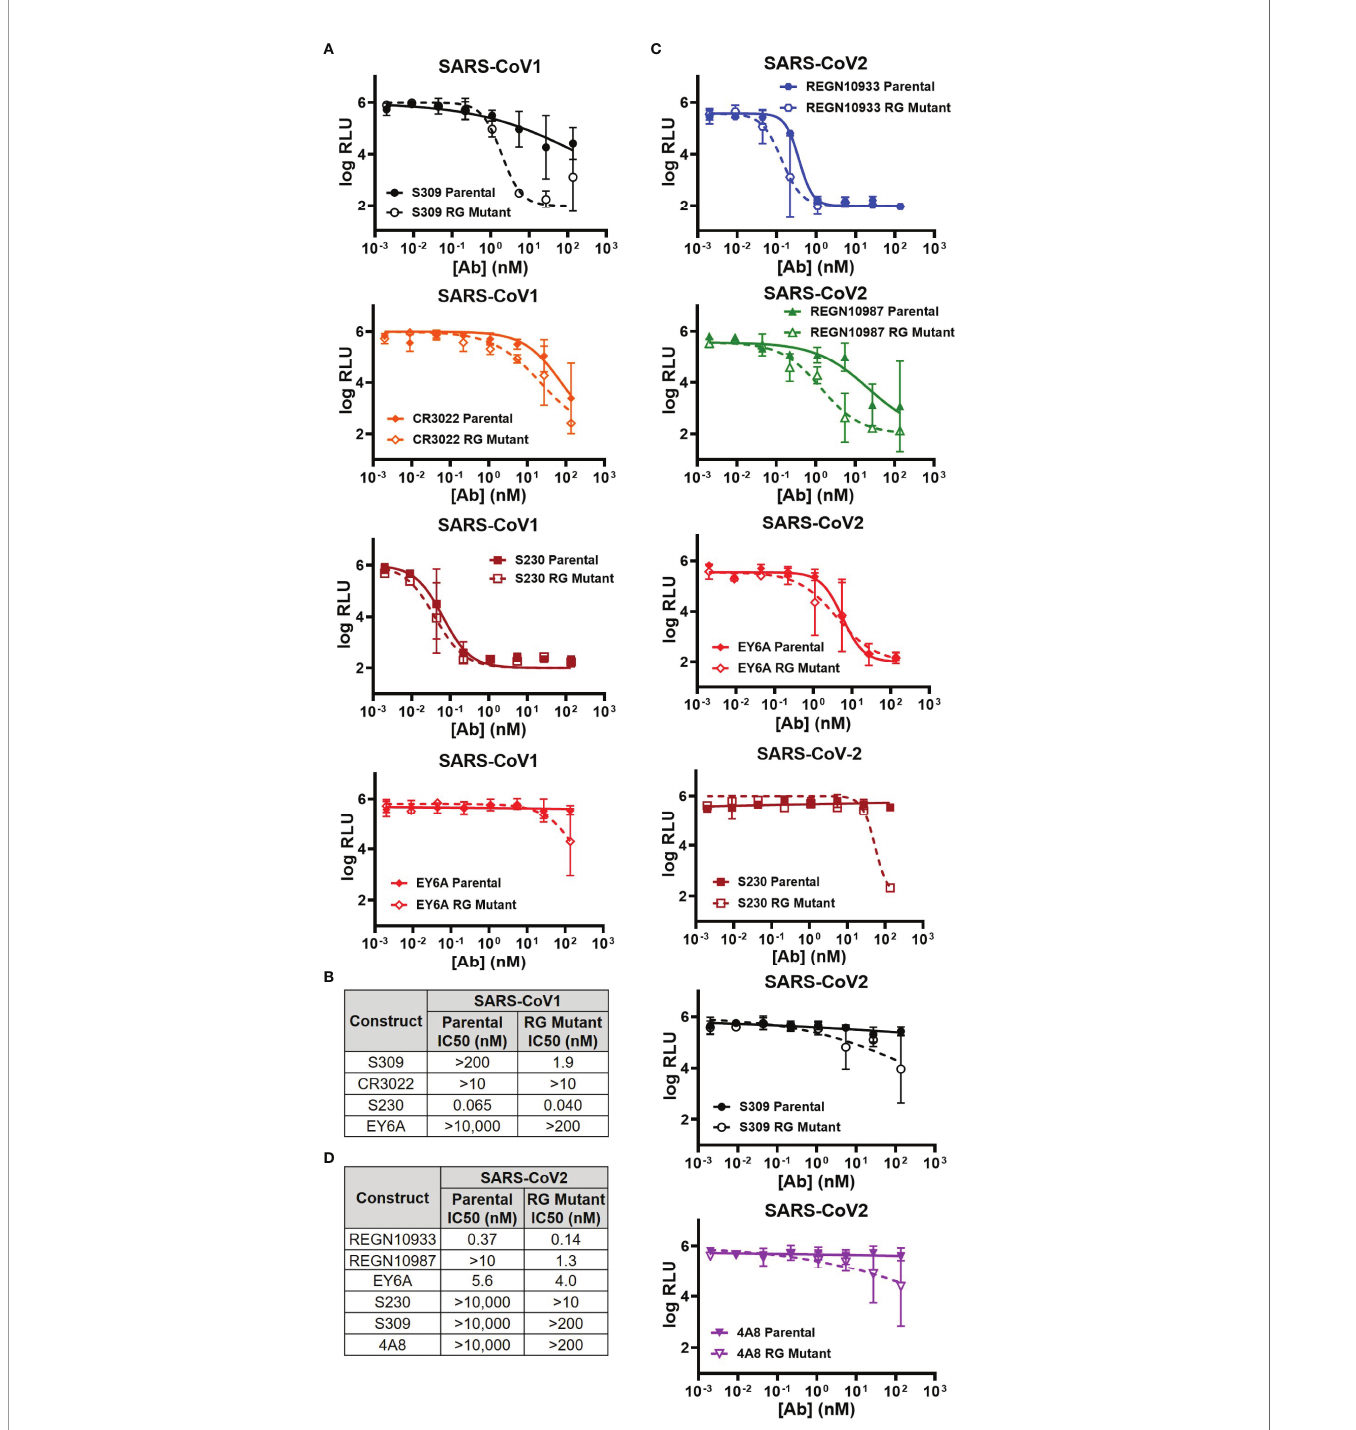
FIGURE 2 | Comparison of the parental and RG mutant antibodies by using rVSV D G-Luc pseudovirus neutralization assay. (A) SARS-CoV1 pseudovirus neutralization by 4 antibodies (S309, CR3022, S230 & EY6A) (mean RLU values with SD; n = 3). (B) Calculated IC 50 neutralization values against CoV1 pseudovirus by RG mutant vs parental. (C) SARS-CoV-2 pseudovirus neutralization by 6 antibodies (REGN10933, REGN10987, EY6A, S230, S309 & 4A8) (mean RLU values with SD; n = 3). (D) Calculated IC 50 neutralization values against CoV-2 pseudovirus by RG mutant vs parental. Data for non-neutralizing constructs may be found in the Supplemental information ( SI Figure 2